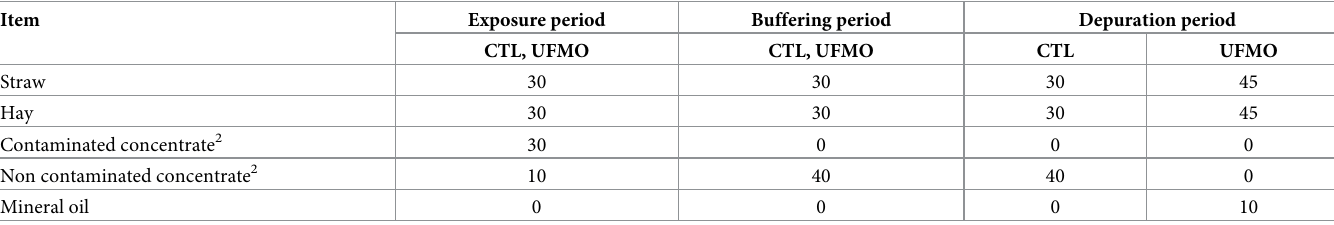
Table 1. Composition of the diets (percentage of the diet dry matter) 1 .